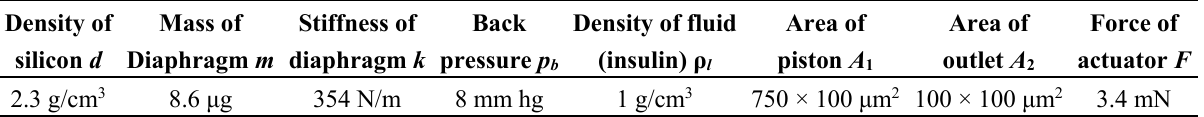
Table 4. Nomenclature of value parameters used in Equation (23) for solving with MATLAB software.